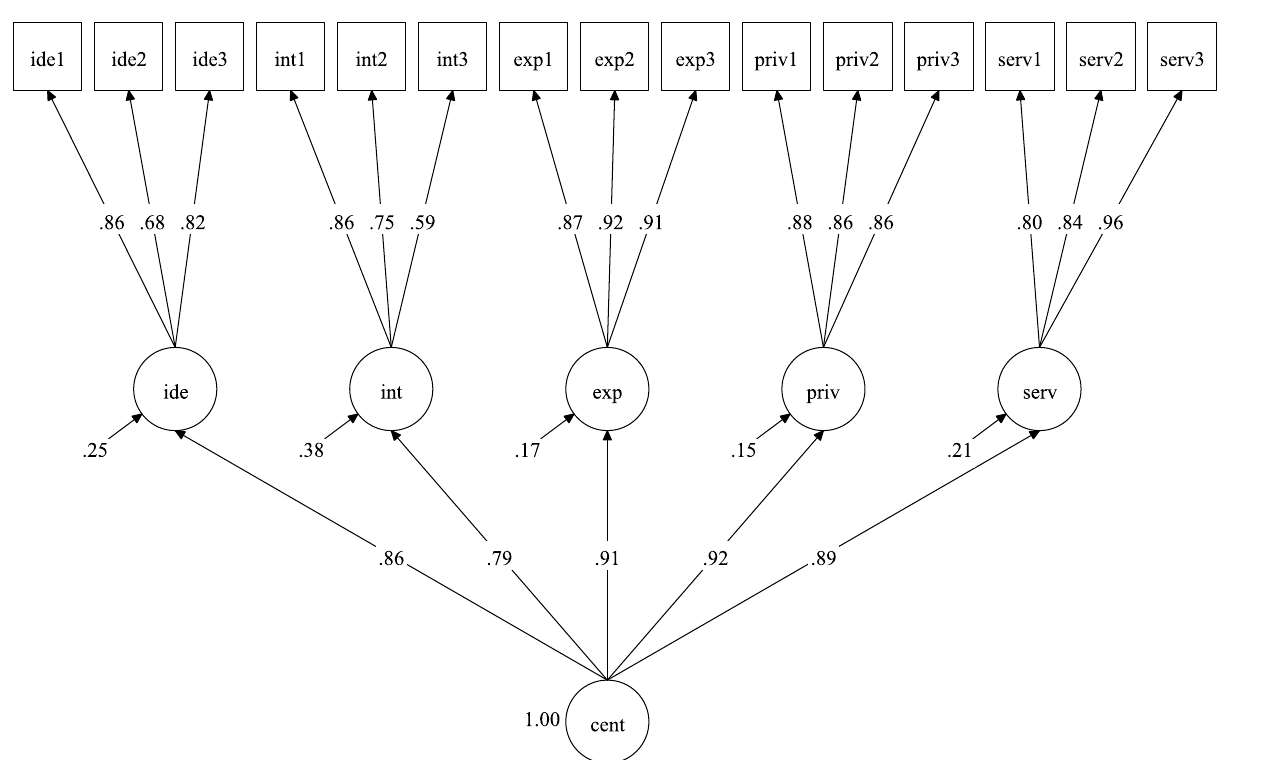
Figure A7. Results of the confirmatory factor analysis of the CRS-15. The numbers in the plot represent standardized estimates. Cent = centrality of religiosity; int = intellect; ide = ideology; serv = public practice; priv = private practice; exp = experience. The number after the item name indicates the position of the item within the core dimension items. Squares depict manifest and circles latent variables. Residual arrows are not shown for the manifest variables. Numbers on arrows are factor loadings. The model is identified by setting the variance of the second level latent variable “cent” and the factor loading of each item with the suffix “1” to be equal 1. All reported estimates are significant at least α ≤ 0.05 level.